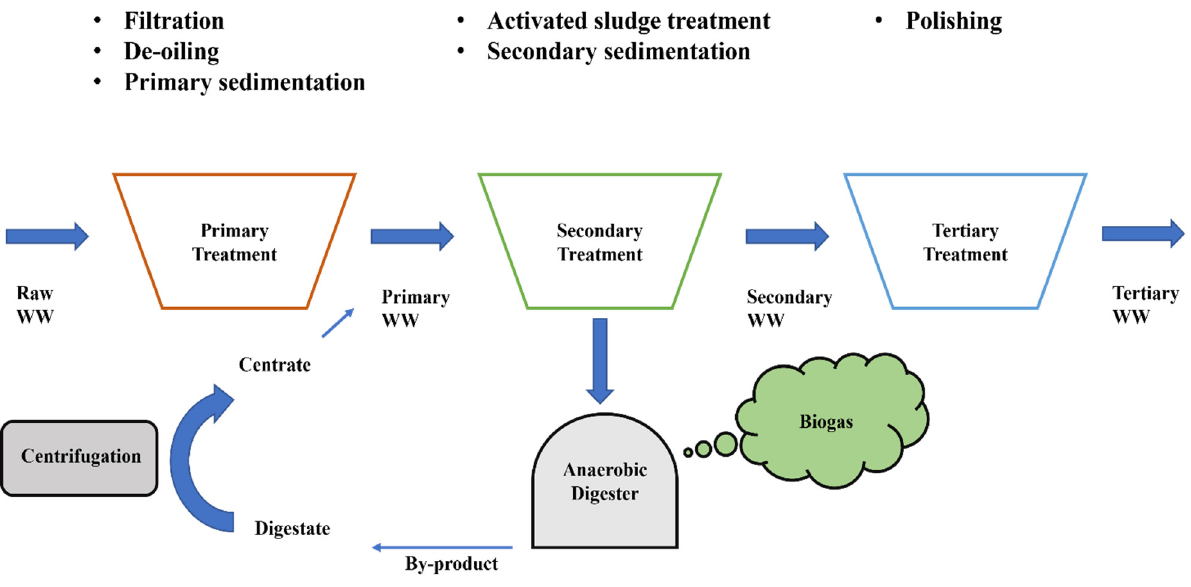
Figure 2. Temporal distribution of publications.